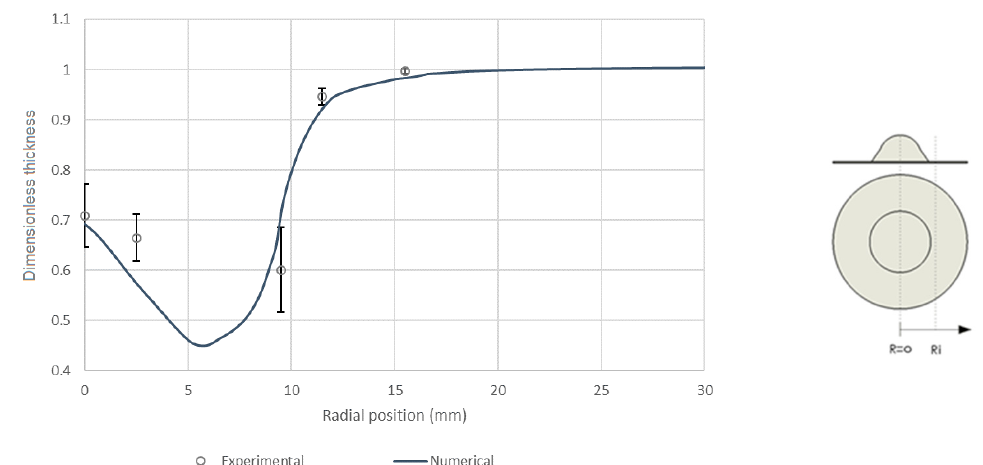
Figure 9. Erichsen test of the EK4 steel: experimental and numerical dimensionless thickness radial profiles at the final fracture stage of the sample.